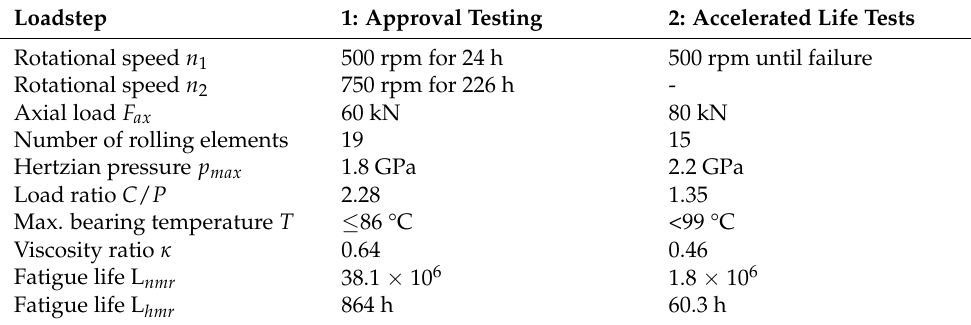
Table 3. Parameters for fatigue